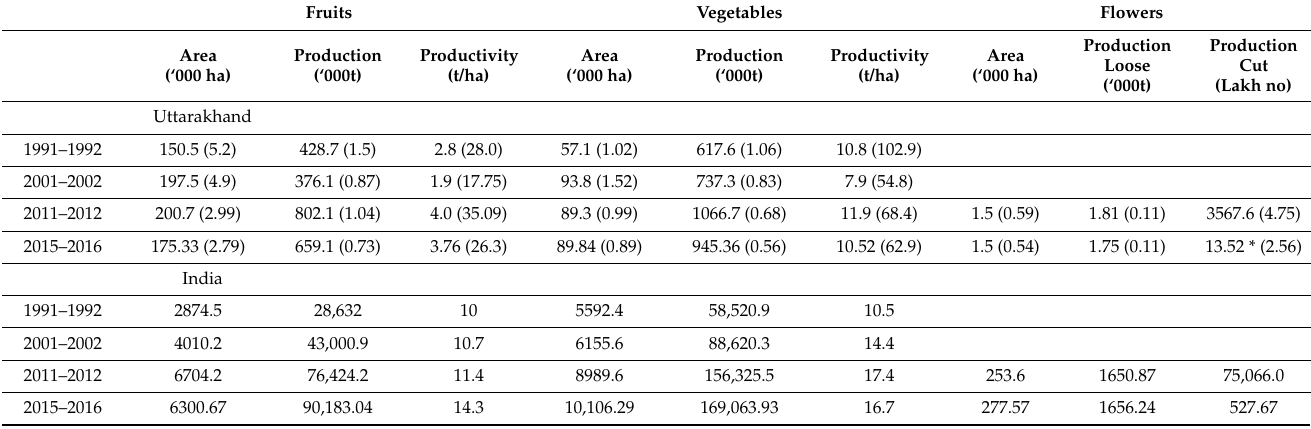
Table 1. Area and production of horticultural crops in